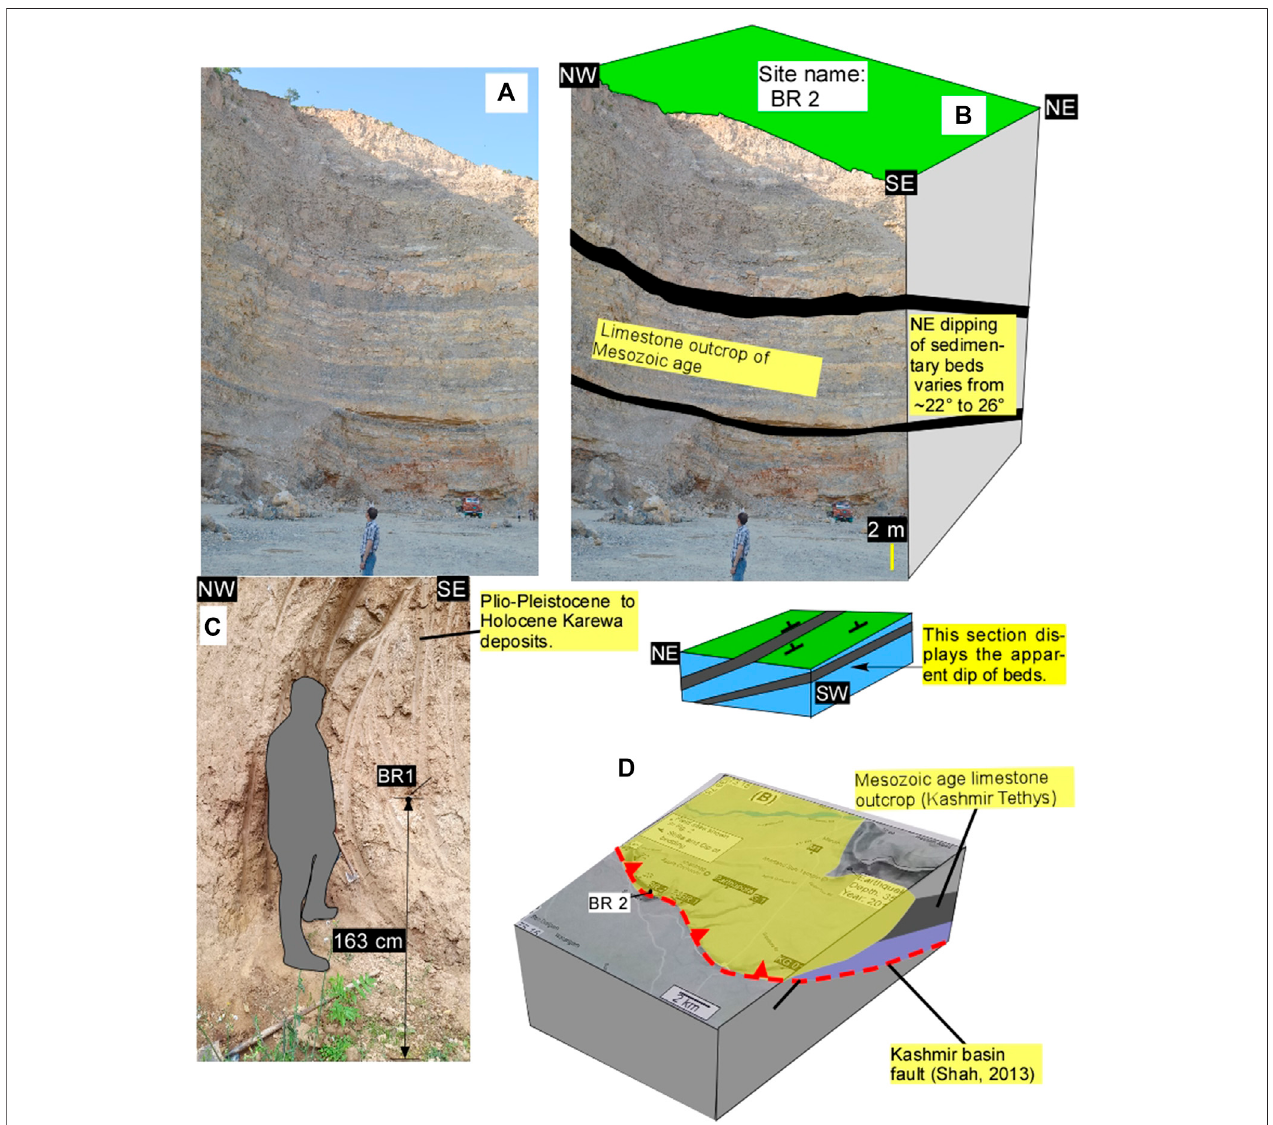
FIGURE 3 | The fi eld evidence of the undeformed Mesozoic carbonate basement rocks that are exposed at a quarry section in Anantnag, Kashmir (location in Figure 1 ) These rocks belong to Kashmir Tethys. The un-interpreted (A) and interpreted (B) fi eld photograph shows the undeformed but tilted Mesozoic carbonate rocks that form the basement on which most of the Kashmir basin resides. The basin is fi lled with Plio-Pleistocene Karewa deposits (C and D) . The exposure of the basement rocks at this location is related to the active faulting (Shah, 2013). The quarry section exposes the apparent dip of the rock units.